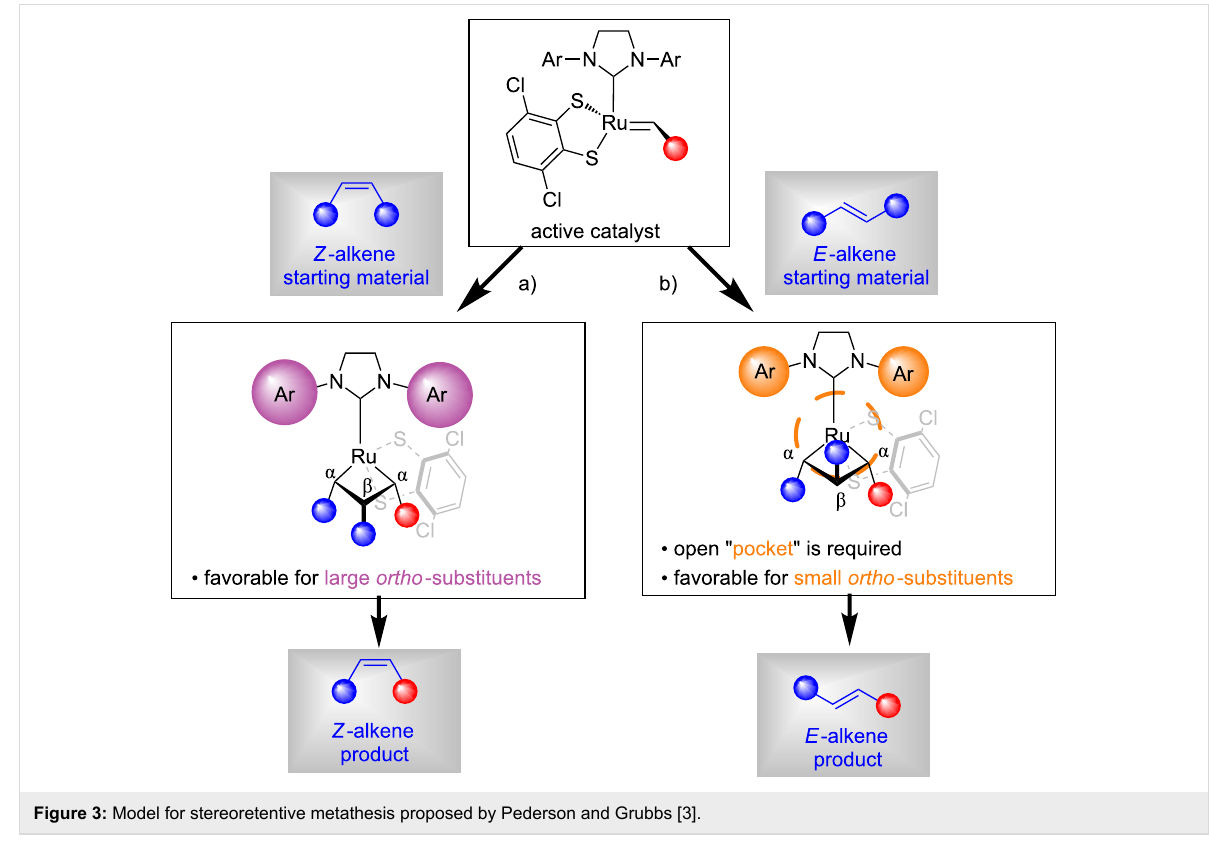
Figure 3: Model for stereoretentive metathesis proposed by Pederson and Grubbs [3].